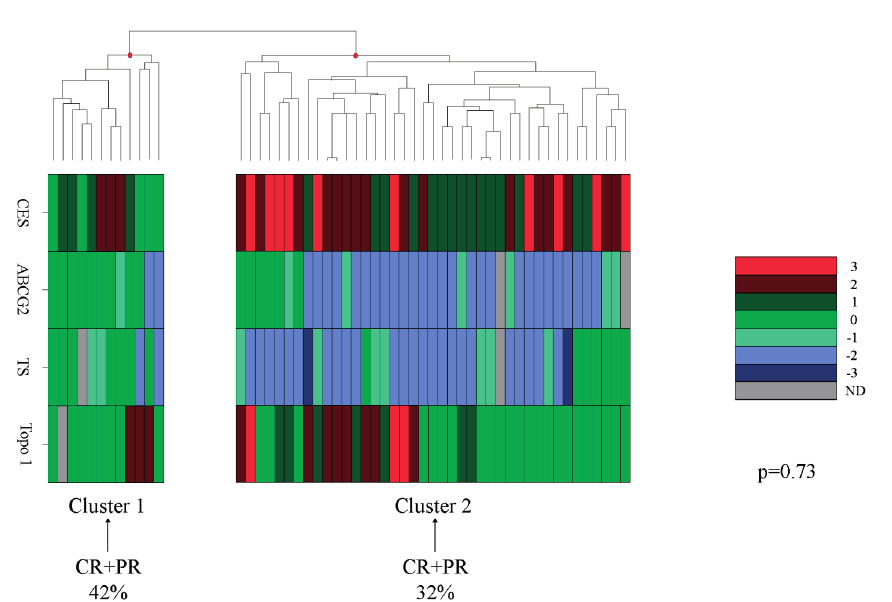
Figure 2. Hierarchical clustering from CES2, ABCG2, TS and Topo-I protein expression performed in 53 metastatic colorectal cancer (mCRC)